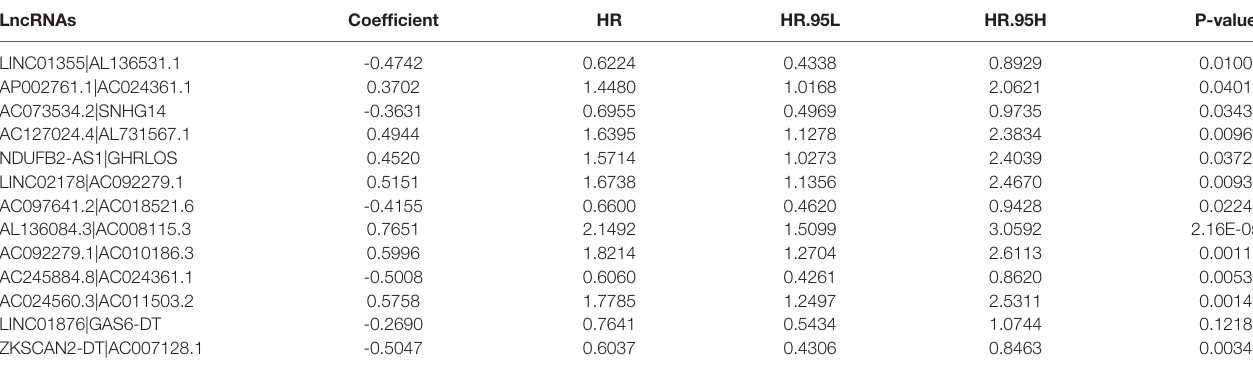
TABLE 1 | Thirteen pairs of prognostic necroptosis-related lncRNA pairs multivariate Cox regression analysis results.